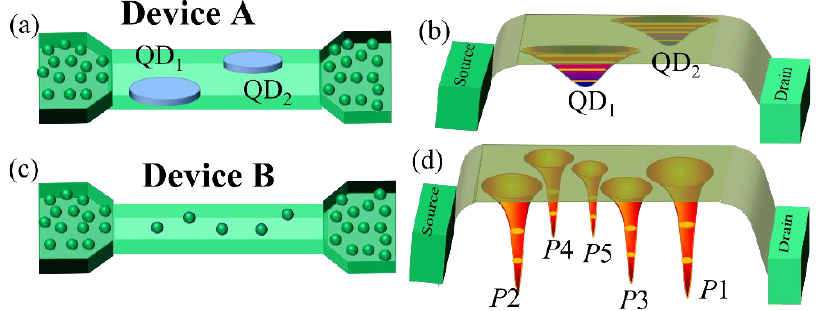
Figure 1. ( a , b ) Schematic device structure and schematic potential configuration of Device-A (with a nominally undoped nanoscale channel). ( c , d ) Schematic device structure and schematic potential configuration of Device-B (with uniformly doped channel).